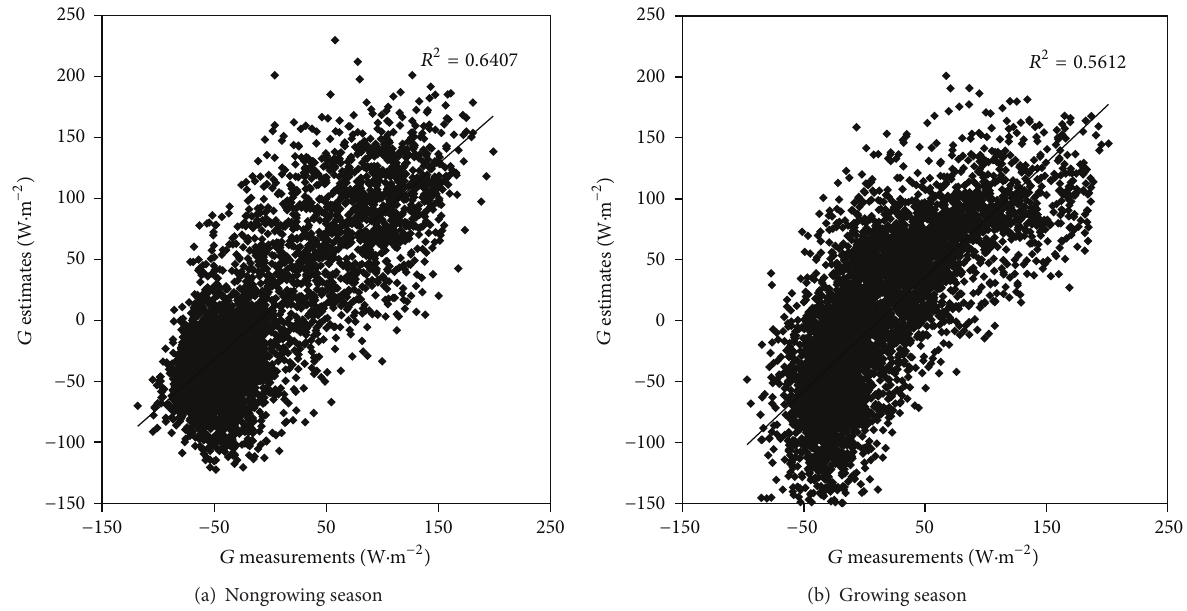
Figure 5: The scatter plots between 𝐺 estimates and 𝐺 measurements for the nongrowing season (a) and for the growing season (b).